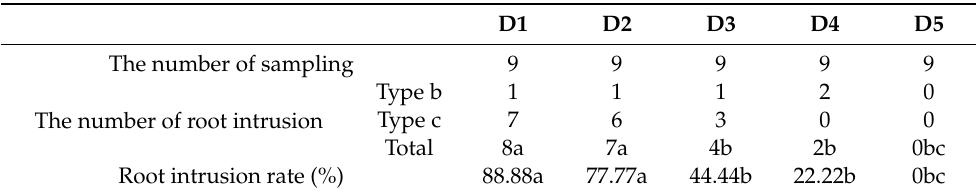
Table 1. Statistics for the anatomical emitters.